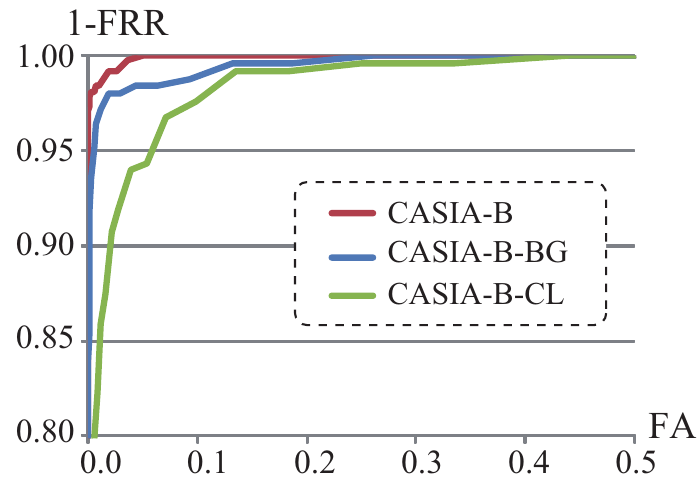
Figure 13. ROC curves by the proposed method (CASIA-B, CASIA-B-BG,